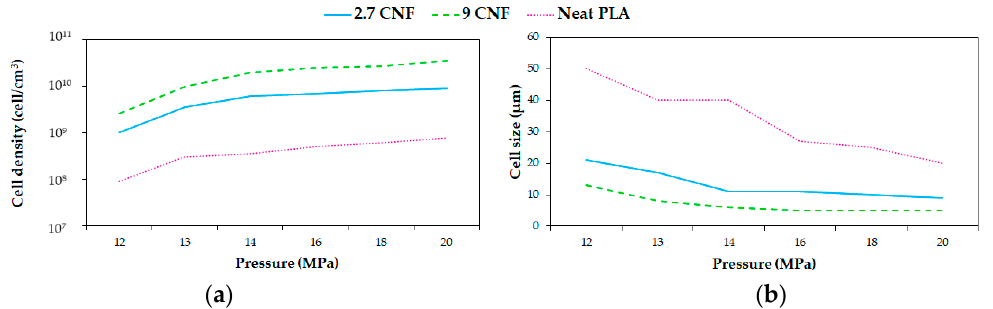
Figure 9. Effect of pressure in ( a ) cell density and ( b ) cell size of PLA/CNFs foams. Data taken from Figure 9. E ff ect of pressure in ( a ) cell density and ( b ) cell size of PLA / CNFs foams. Data taken from Dlouhá et al. [126]. Dlouh á et al.